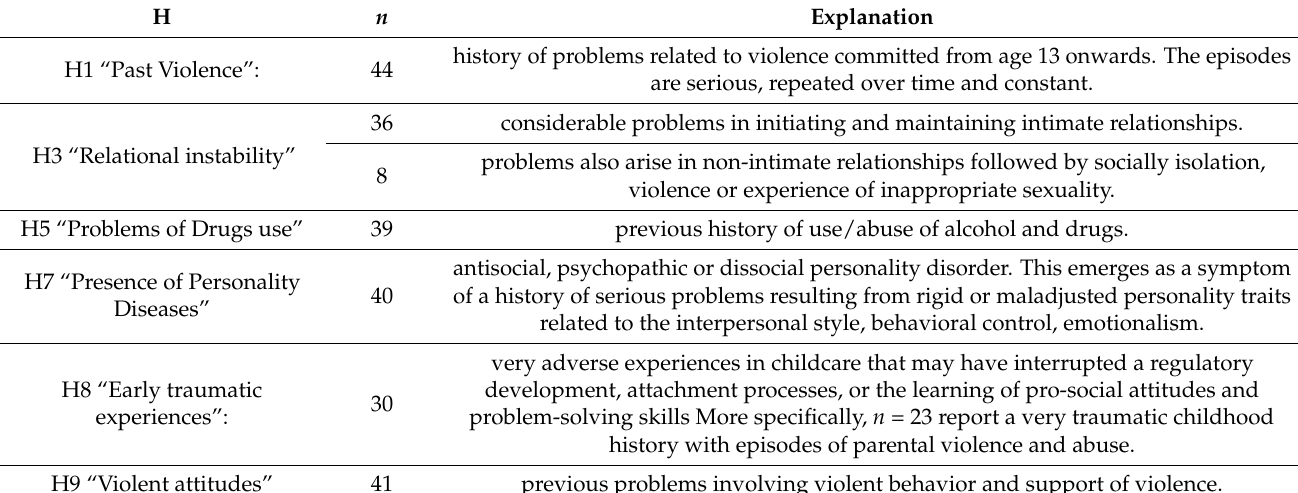
Table 1. HCR20v3 items resulted